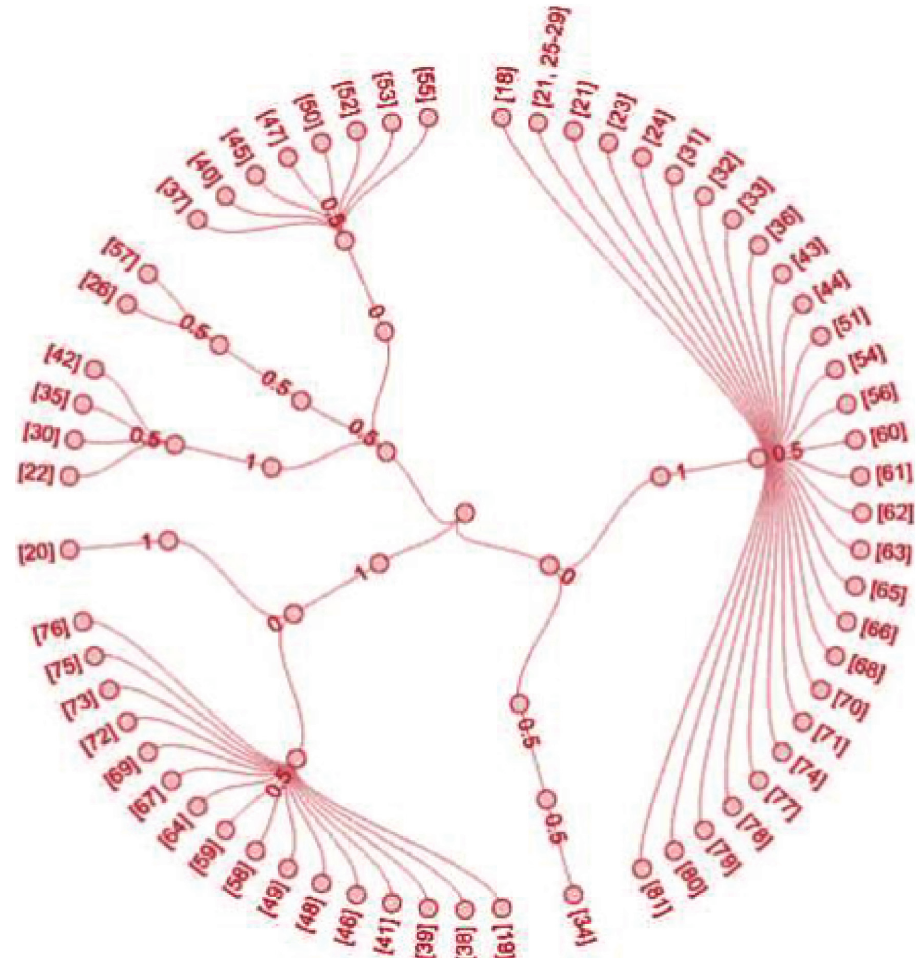
Figure 15: Quality evaluation of the selected